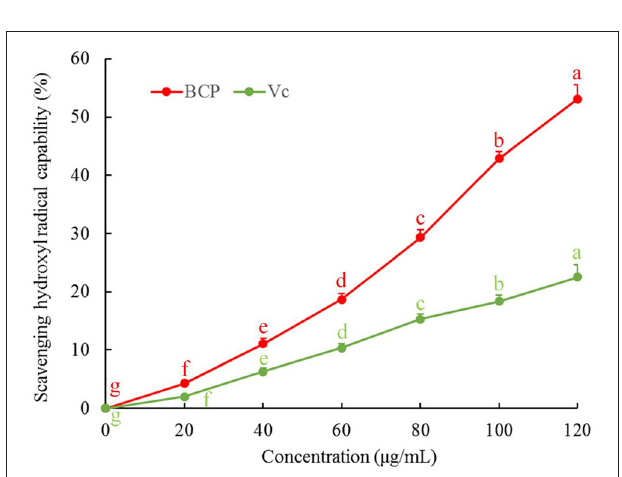
FIGURE 4 | Hydroxyl radical scavenging capacity of blood cora polysaccharides. a − g Mean values with different letters over the bar are significantly different ( P < 0.05) according to Tukey’s honestly significant